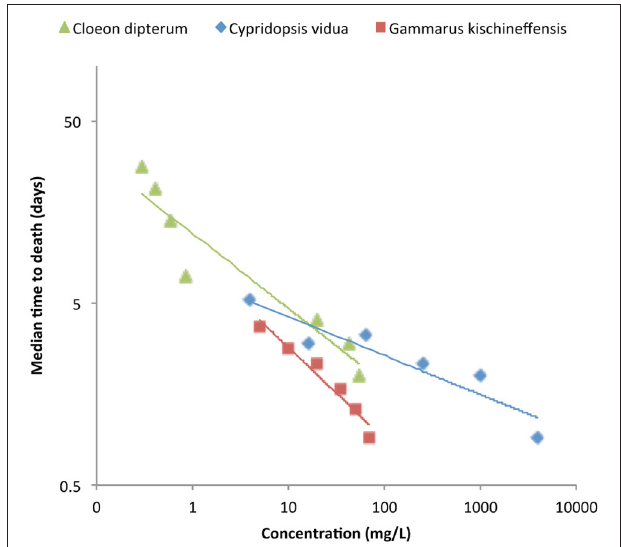
FIGURE 1 | Time-cumulative mortality of three aquatic species exposed to neonicotinoids: mayfly Cloeon dipterum to thiacloprid (green triangles), ostracod Cypridopsis vidua to imidacloprid (blue diamonds) and amphipod Gammarus kischineffensis to thiamethoxam (red squares). Data sources: mayfly ( van den Brink et al., 2016); ostracod (Sánchez-Bayo, 2009); amphipod (U ˘ gurlu et al.,